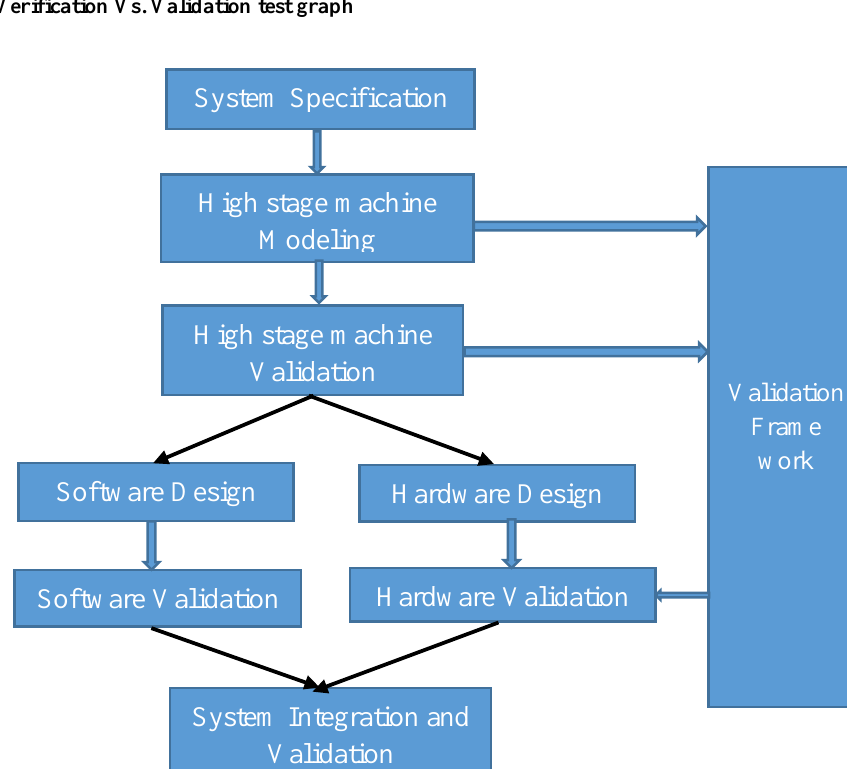
Fig. 1. Verification Vs. Validation test graph